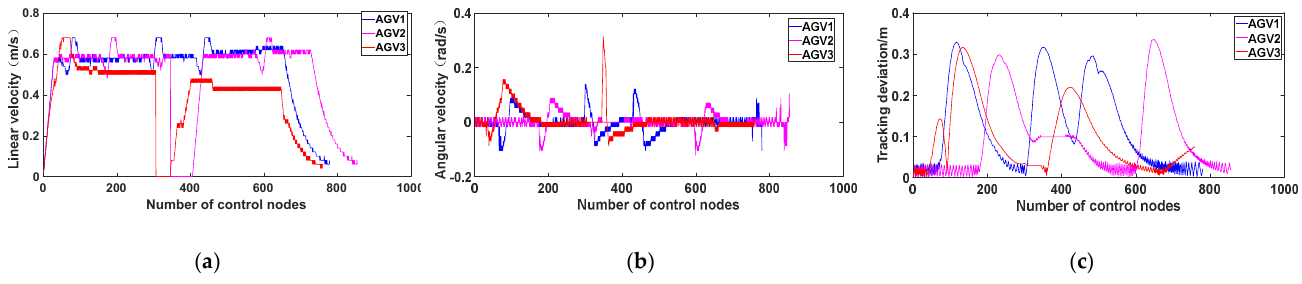
Figure 22. Multi−robot parameter comparison. ( a ) Comparison of linear velocity. ( b ) Comparison of angular velocity. ( c ) Comparison of tracking deviation. Table 7. Multi-robot path planning results in a known static environment.